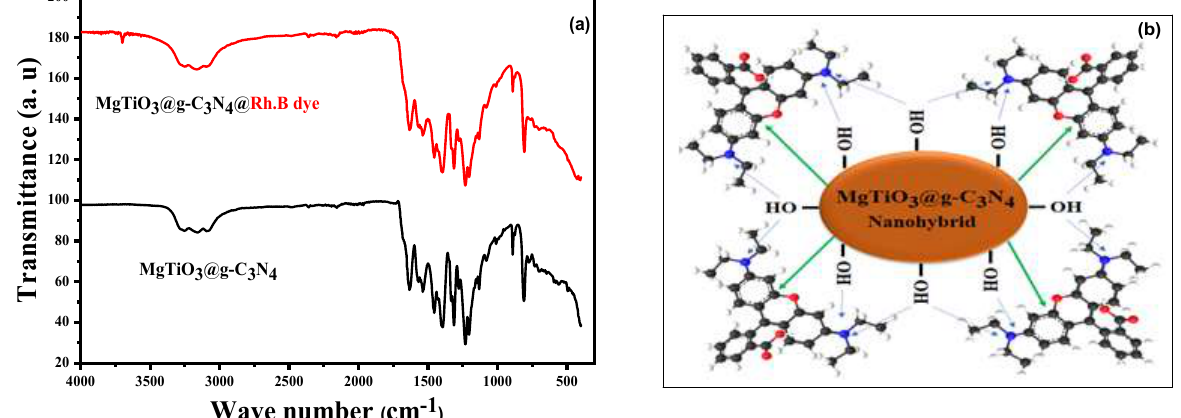
Figure 8. FTIR spectra of ( a ) MgTiO 3 @g-C 3 N 4 @RhB before and after adsorption, and ( b ) proposed adsorption mechanism.